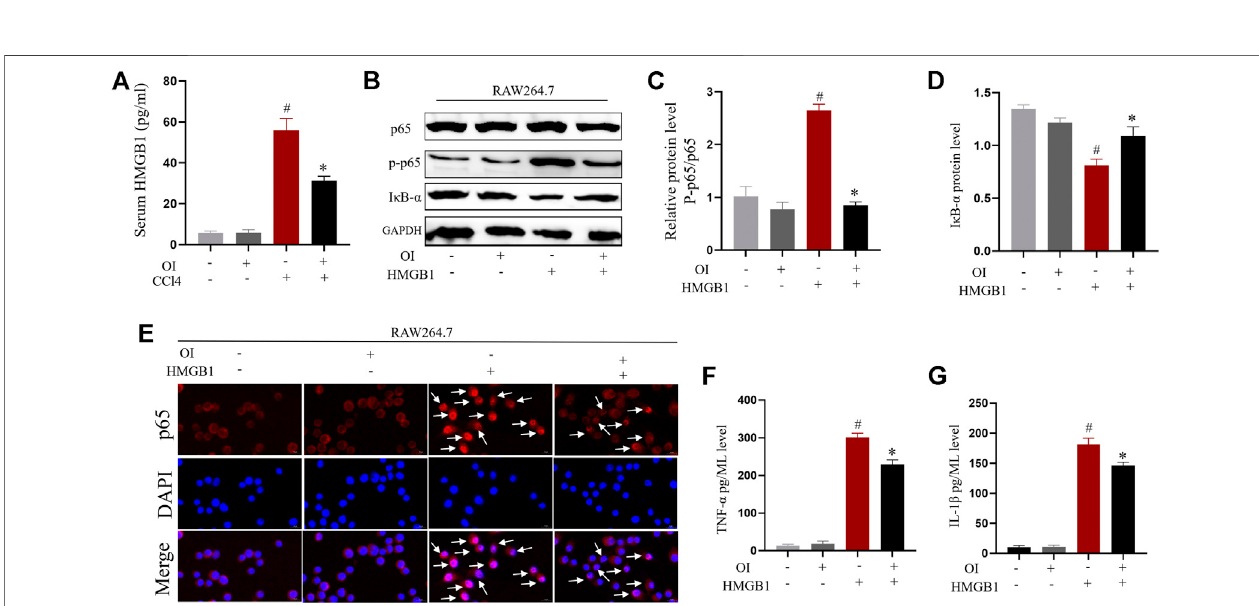
FIGURE 7 | OI reduced HMGB1-induced activation of the NF- κ B pathway and inhibited pro-in fl ammatory cytokine synthesis in RAW 264.7 cells. (A) Serum levels ofHMGB1wereanalyzed ineach group( n (cid:1) 5). (B) Representativeimmunoblotimages ofNF- κ Bp65,Phosphate-p65(p-p65), and I κ B- α foreach group inRAW264.7; Gapdh was used as an endogenous control. Analysis of the p-p65/p65 ratio (C) and I κ B- α protein level (D) of each group. (E) Representative immuno fl uorescence detection nuclear translocation of p65 from each group in RAW 264.7 cells. Translocation of p65 is marked with a white arrow. The levels of pro-in fl ammatory cytokines such as TNF- α (F) and IL-1 β (G) in RAW264.7 cell supernatant from each group were analyzed. Original magni fi cation, × 400. Data are expressed as mean ± SEM. All experiments were performed three times independently. # p < 0.05 vs. control group; * p < 0.05 vs. CCl4 group.